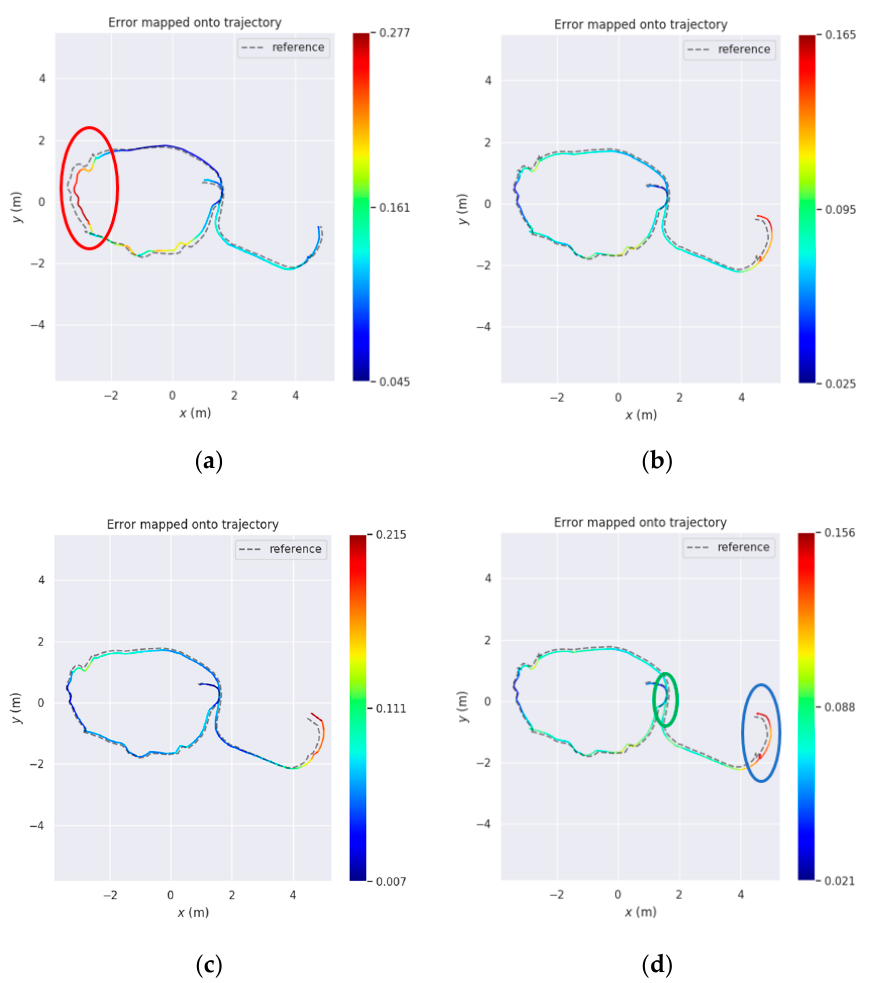
Figure 8. Comparison of estimated trajectories with ground truth on room sequence. ( a ) Point; ( b ) Point + 3D Line; ( c ) Point + 2D Line; ( d ) Proposed. ( b ) Point + 3D Line; ( c ) Point + 2D Line; ( d )